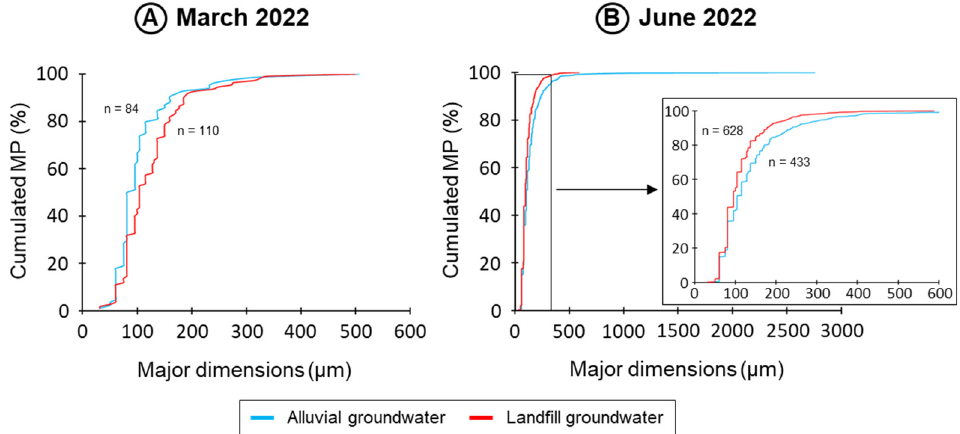
Figure 6. Cumulated size distributions of MP between the alluvial (considering W6, Pz16, Pz5b and Pz9b) and landfill groundwater bodies (considering Pz11 and Pz7) in ( A ) March and ( B ) June